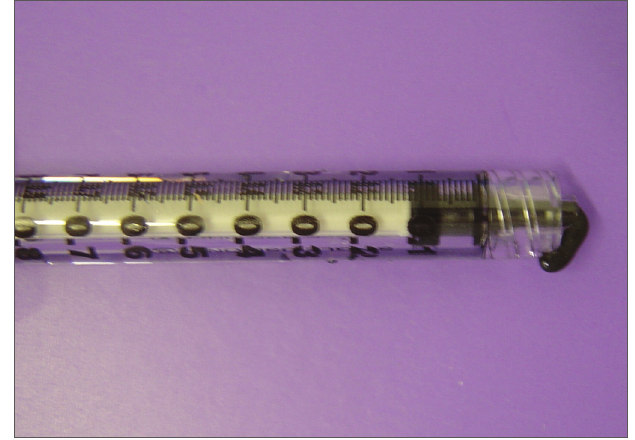
Figura 1. Durasphere em uma seringa de